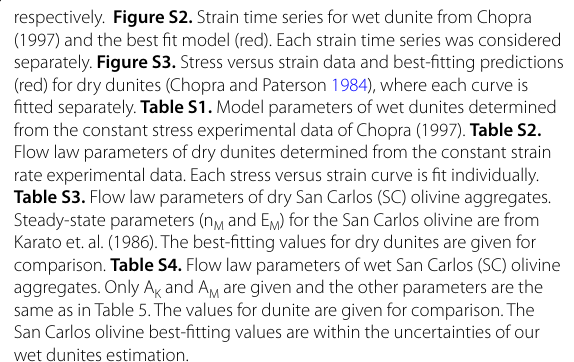
Fig. 10 Deformation mechanism maps drawn using the flow law parameters from this study for wet DisGBS. Under asthenospheric conditions, DisGBS can be dominating and the flow law parameters determined in this study may be applicable for postseismic studies. We use the water content exponent and activation volume of 0.35 and 8 cm 3 /mol corresponding to [110] c orientation. Under wet condition and at high temperatures, the [100](010) slip-system controls the steady-state creep (Masuti et al. 2019). For the dislocation and diffusion creep, we use the flow law parameters from Hirth and Kohlstedt